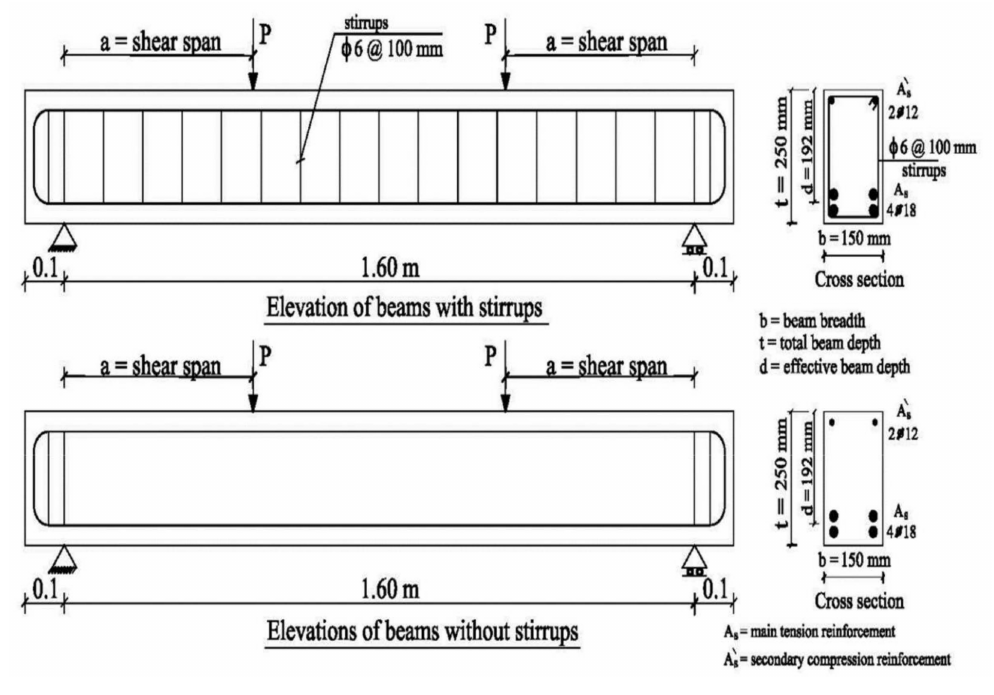
Figure 2. Details of the tested beams.